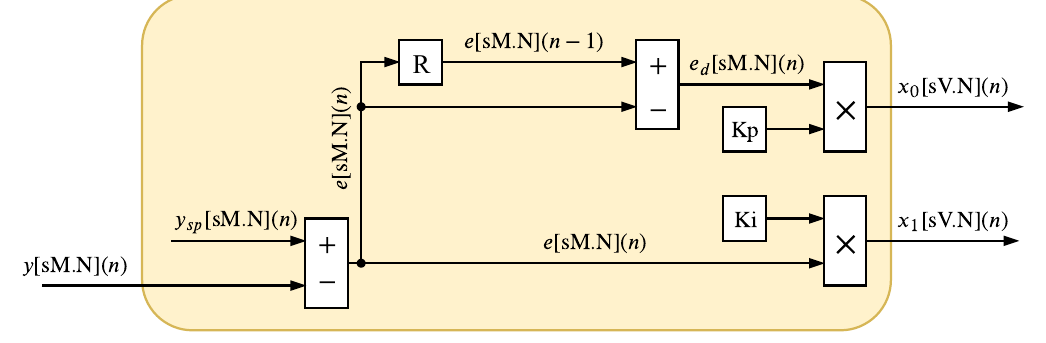
Figure 3. Hardware architecture of